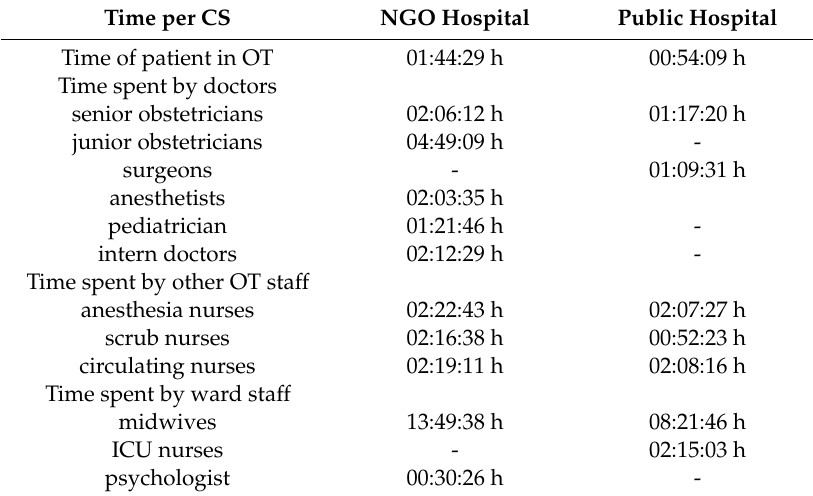
Table 4. Average time spent per